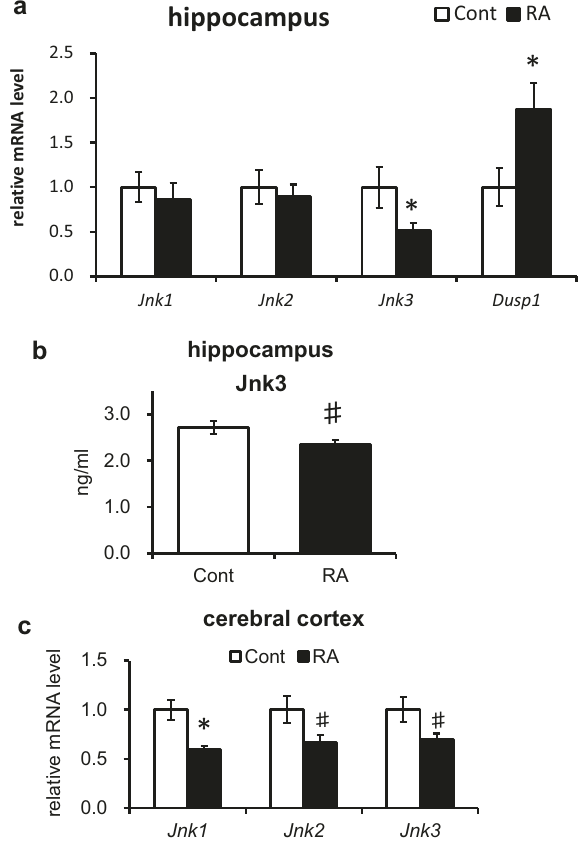
Fig. 5 The effects of RA on JNK expression. a Quanti fi cation of Jnk and Dusp1 genes in hippocampus using quantitative RT-polymerase chain reaction (PCR). b Quanti fi cation of JNK3 levels in hippocampus using enzyme-linked immunosorbent assay ( p = 0.077). c Quanti fi - cation of Jnk genes in cerebral cortex using qRT-PCR. Jnk1 , p = 0.034; Jnk2 , p = 0.072; Jnk3 , p = 0.066. All mRNA species were quanti fi ed relative to the expression of glyceraldehyde-3-phosphate dehydro- genase ( Gapdh ) and presented as fold changes compared to control (Cont). Data are shown as means ± standard error. Cont, n = 8; RA, n = 9, * p < 0.05, # p <